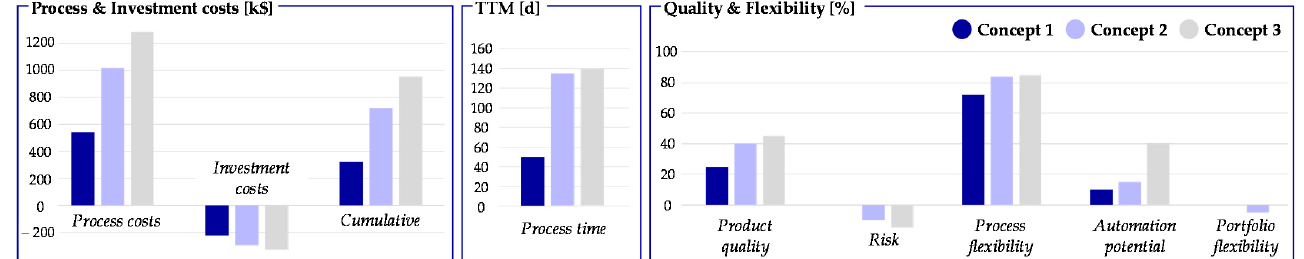
Figure 14. Final comparison of the concepts for the economic target values (positive values represent savings).